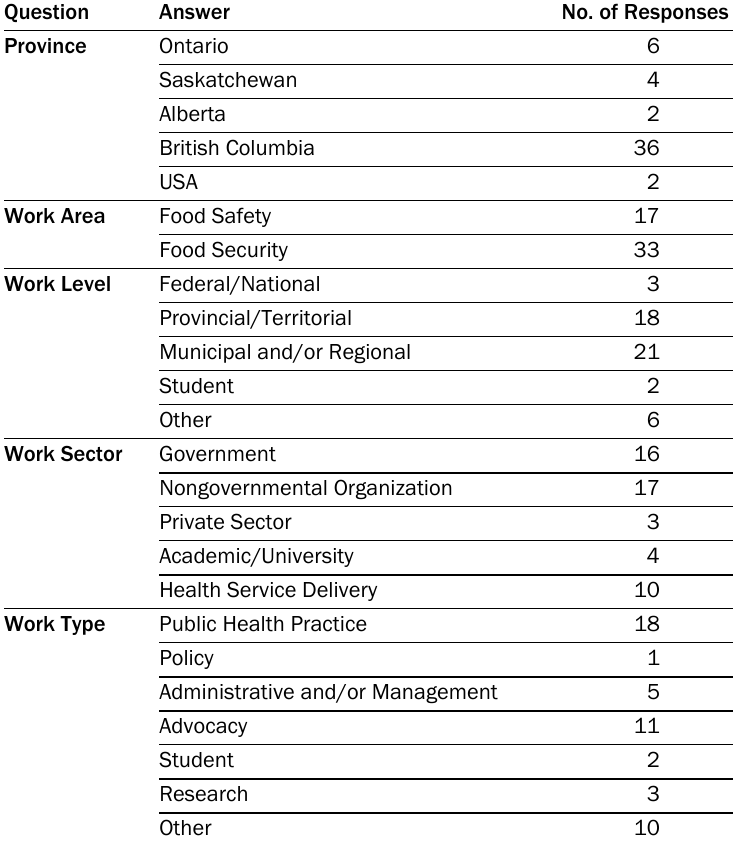
Table 1. Demographics of Participants in Concept Mapping ( N =50)